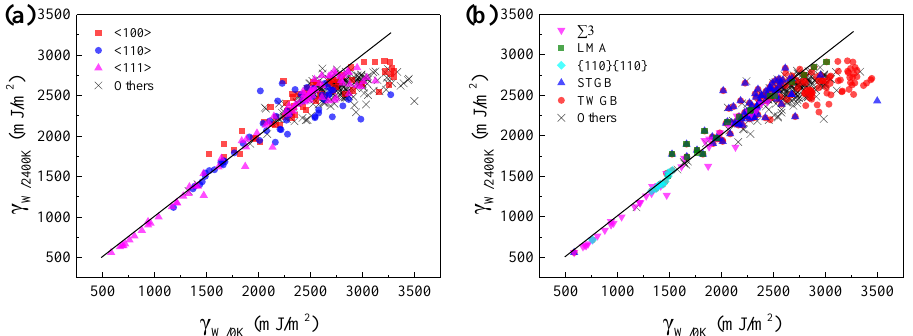
Figure 4. The comparison of GBEs of W at 0 and 2400 K. Every point in ( a , b ) corresponds a GB and the horizonal and vertical coordinates of every point correspond to the GBEs of the GB in W at 0 and 2400 K, respectively. The points in ( a ) are classified according to the misorientation axis of GBs, while the points in ( b ) are classified into ∑3 GBs, low misorientation angle (LMA) GBs, {110}{110} GBs, symmetric tilt grain boundaries (STGBs), twist grain boundaries (TWGBs), and other GBs. The black lines with slope of 1 were drawn for comparison.